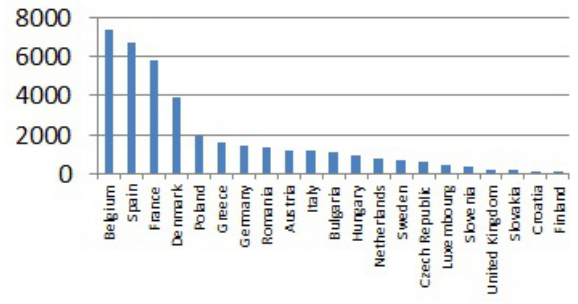
Figure 9. Global ERTMS vehicles contracted in